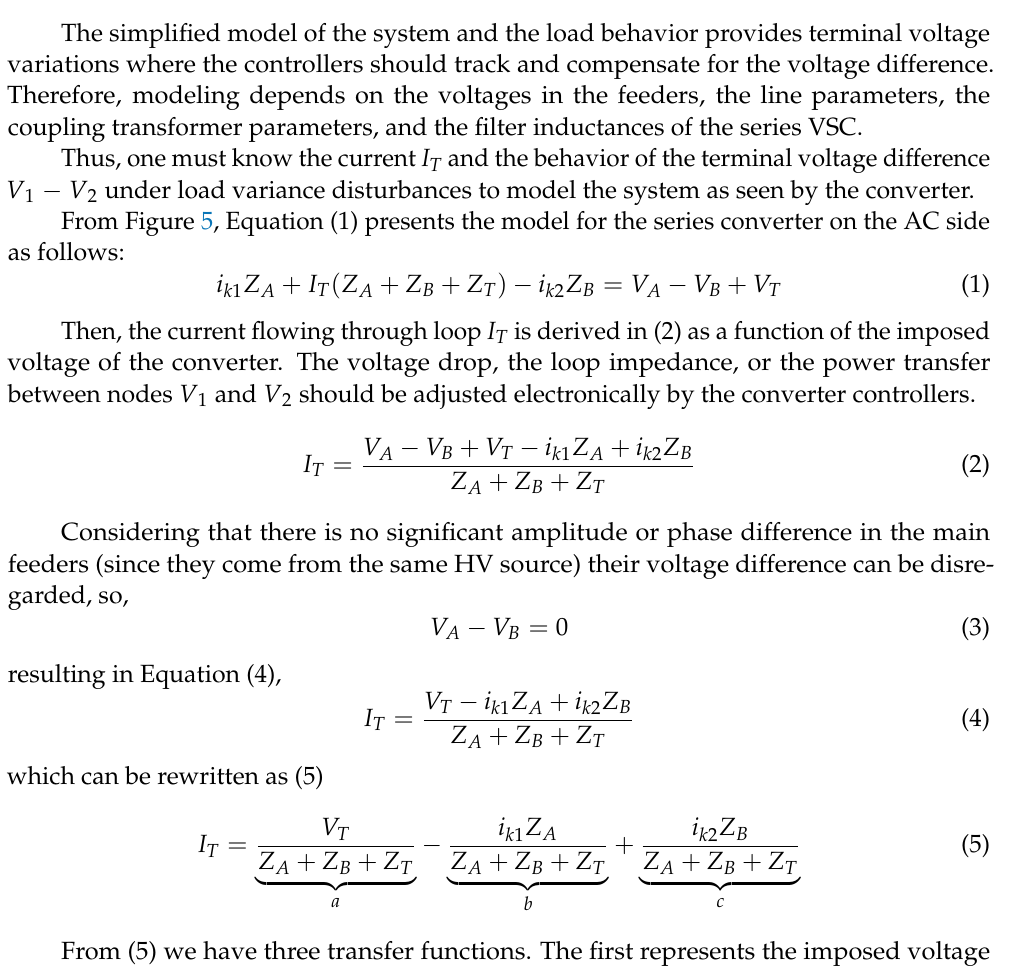
Figure 5. VSC controlled voltage source representation with loads as current sources.